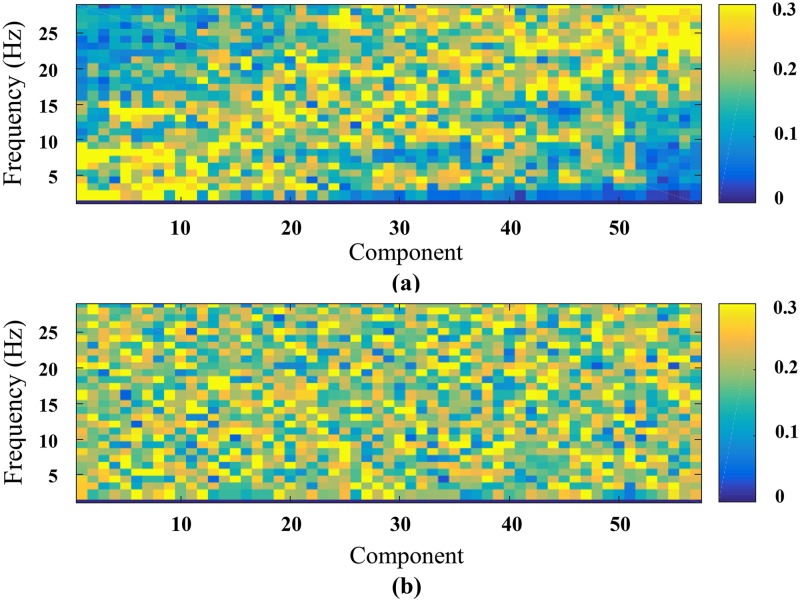
Magnitude spectrum representation.Magnitude Spectrum for each signal obtained through graph-to-signal transformation for a. Error responses; b. Correct responses. The spectrum of error response suggests an organised structure as the frequency content of the signals increases with the signal number whereas the spectrum for the correct responses suggest a random network structure.